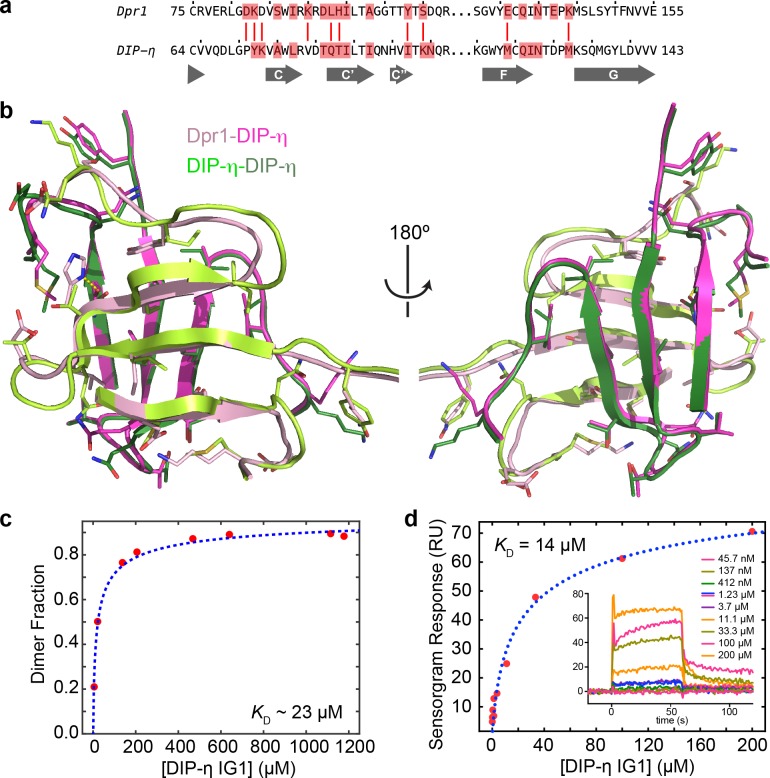
Structural comparison of Dpr1–DIP-η and DIP-η–DIP-η complexes.(a) Non-conservative differences (red sticks) between Dpr1 and DIP-η residues at the interface (red boxes), which share DIP-η as binding partner. (b) Large structural differences exist between the homo- and heterodimeric complexes, even on the common DIP-η subunit (magenta and dark green) of the two complexes. (c) The effects of DIP-η concentration on its oligomeric state plotted, which can be fit to a binding isotherm as an approximation. Concentration of DIP-η was estimated by calculating the loaded protein amount by the area under the peaks in the chromatograms (Figure 5e), divided by the sample loading volume (0.5 ml), and is therefore an overestimate due to dilution effects in gel filtration chromatography. Dimer fraction was calculated by identifying monomeric and dimeric elution velocities, and calculating monomer and dimer fractions for any given peak position. (d) SPR measurement for homodimeric DIP-η D1-D1 binding. Data were fit in MATLAB using equations that account for DIP-η dimerization in the analyte (in solution). To minimize dimerization of ligand (on chip), biotinylated DIP-η was captured at a low density, yielding a 98 R.U. maximal response.